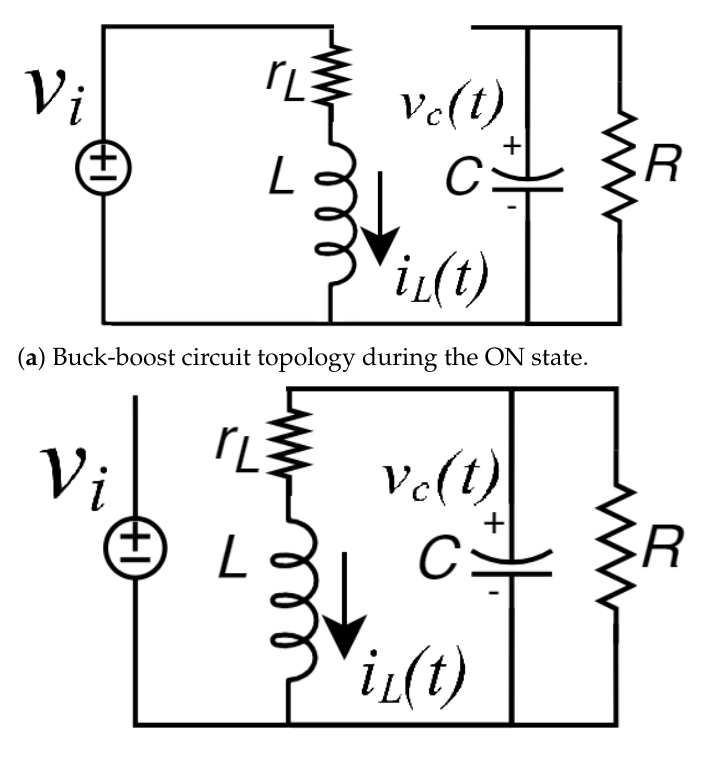
Figure 4. Buck-boost converter circuit stages, ( a ) On state; ( b ) OFF